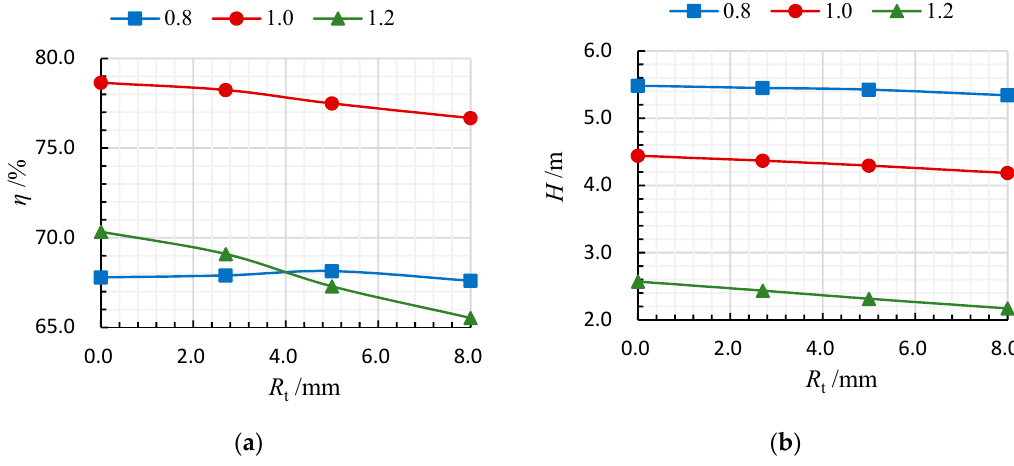
Figure 7. Comparison of simulated ( a ) hydraulic efficiency and ( b ) head under different root clearance radii.